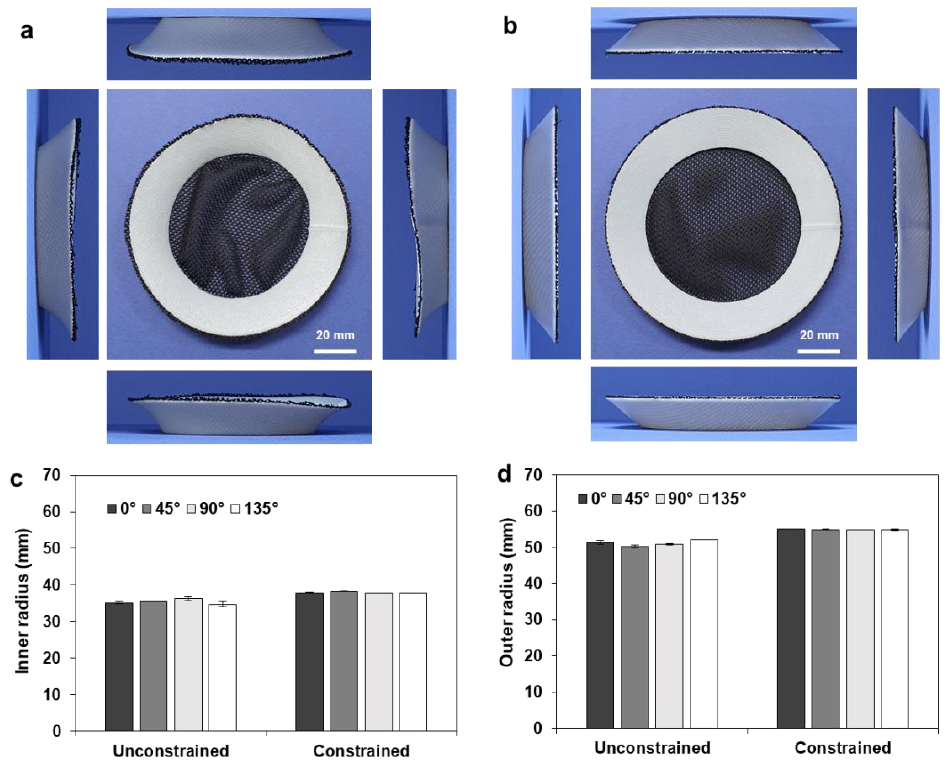
Figure 14. Deformed shape of the composite frame ( r = 60, w = 20 mm): ( a ) unconstrained defor- mation; ( b ) constrained deformation; ( c ) comparison of the inner radius ( r i *); ( d ) comparison of the outer radius ( r o *).